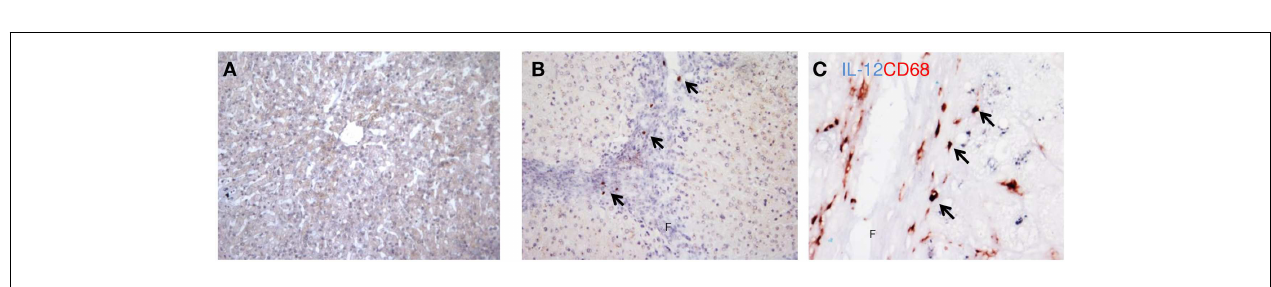
IL-12 and CD68. Arrows indicate co-localization, f, fibrotic matrix. Magnifications: 100 × (A,B) and 400 × (C) . N = 5 cirrhotic livers, N = 6 normal